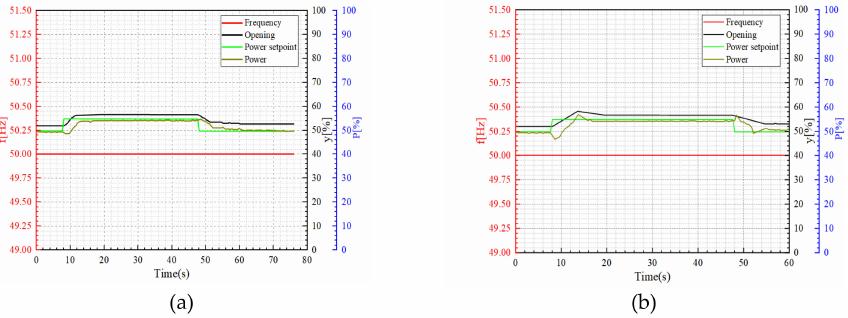
Figure 8. Power regulation with 5% rated power change. ( a ) The S-curve control strategy; ( b ) The conventional linear control